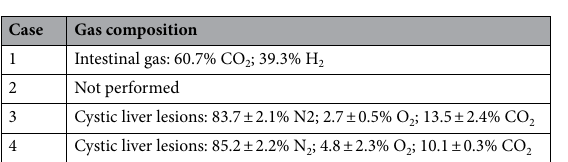
Table 2. Gas composition analysis results in dolphins included in this